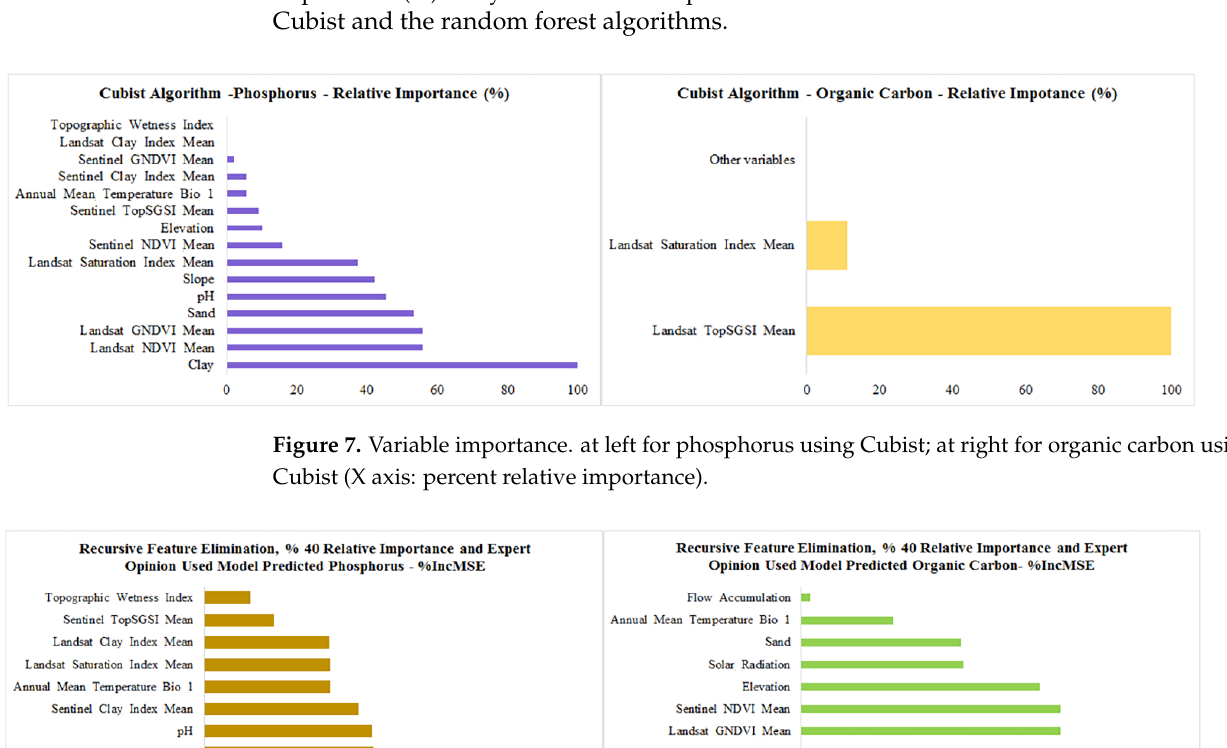
Figure 7. Variable importance. at left for phosphorus using Cubist; at right for organic carbon using Cubist (X axis: percent relative importance).